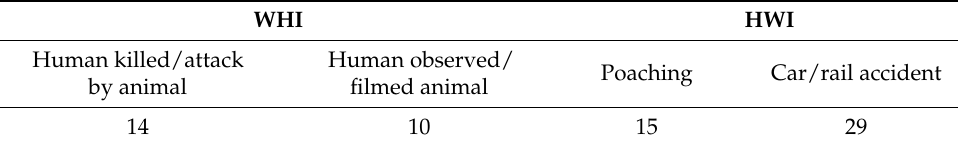
Table 1. Number of resources acquired for major types of WHI and HWI. WHI HWI Human killed/attack Human observed/ by animal filmed animal